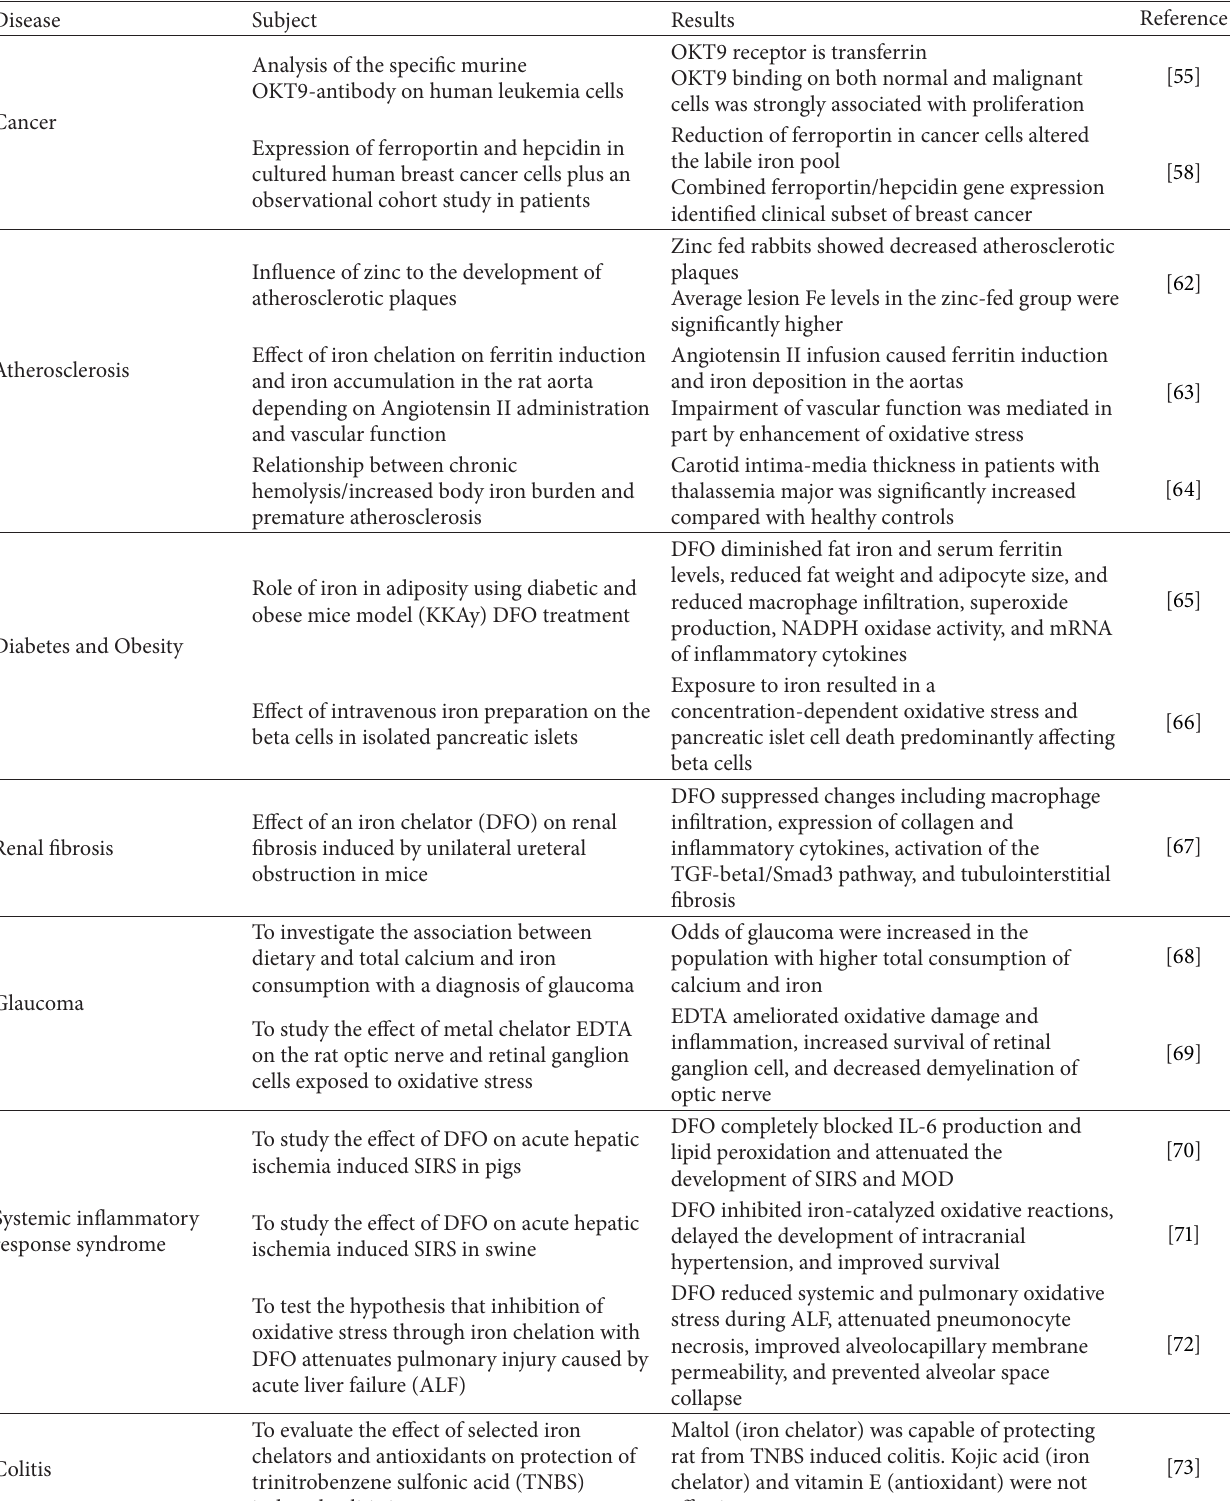
Table 1: Selected experimental